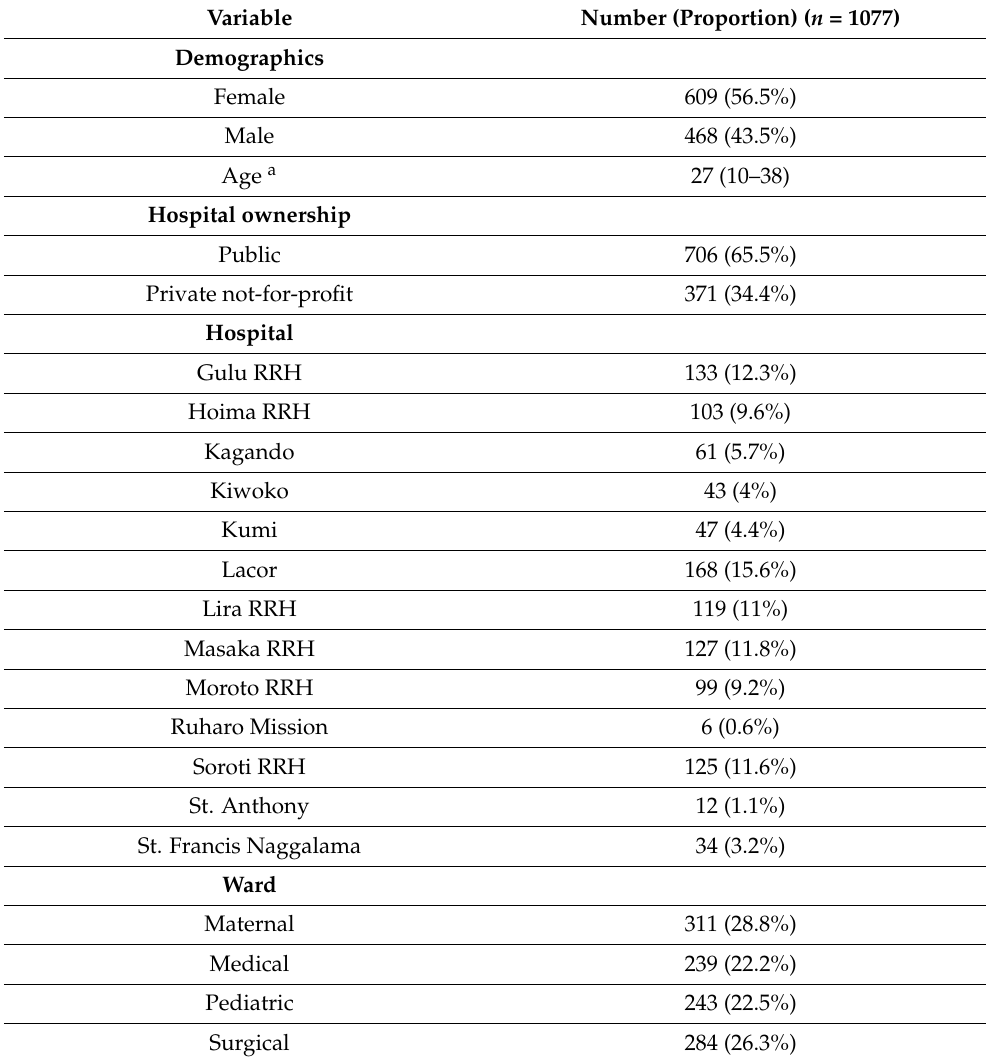
Table 1. Demographic and clinical characteristics of enrolled patients ( n =